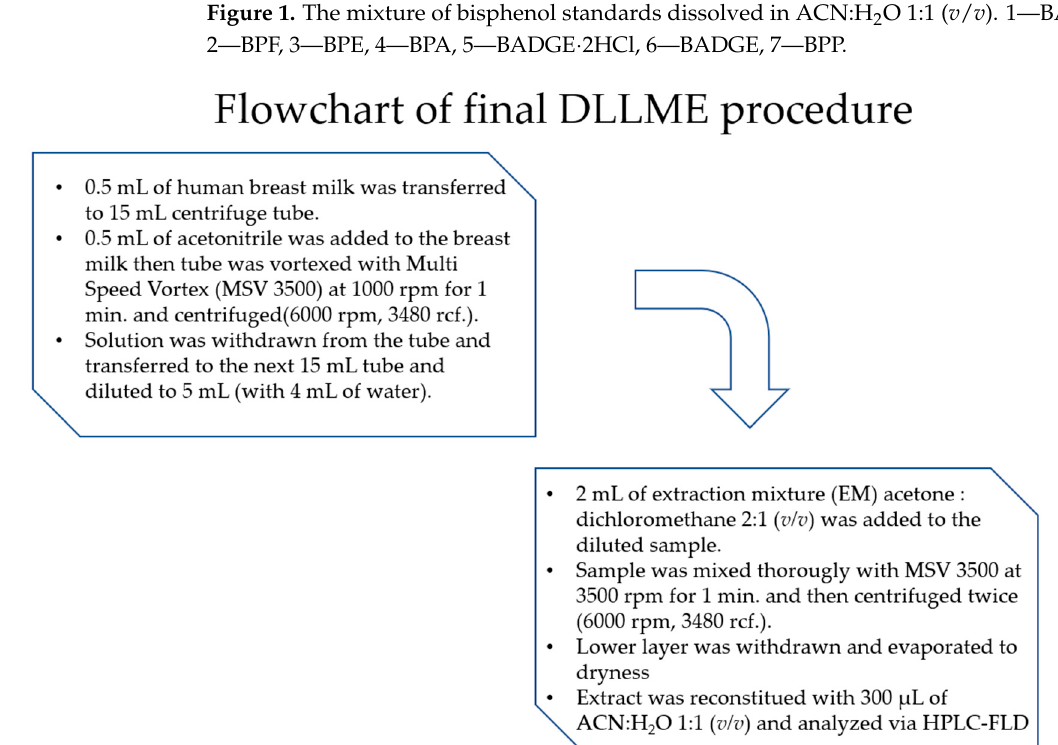
Figure 2. The flowchart of final DLLME procedure.